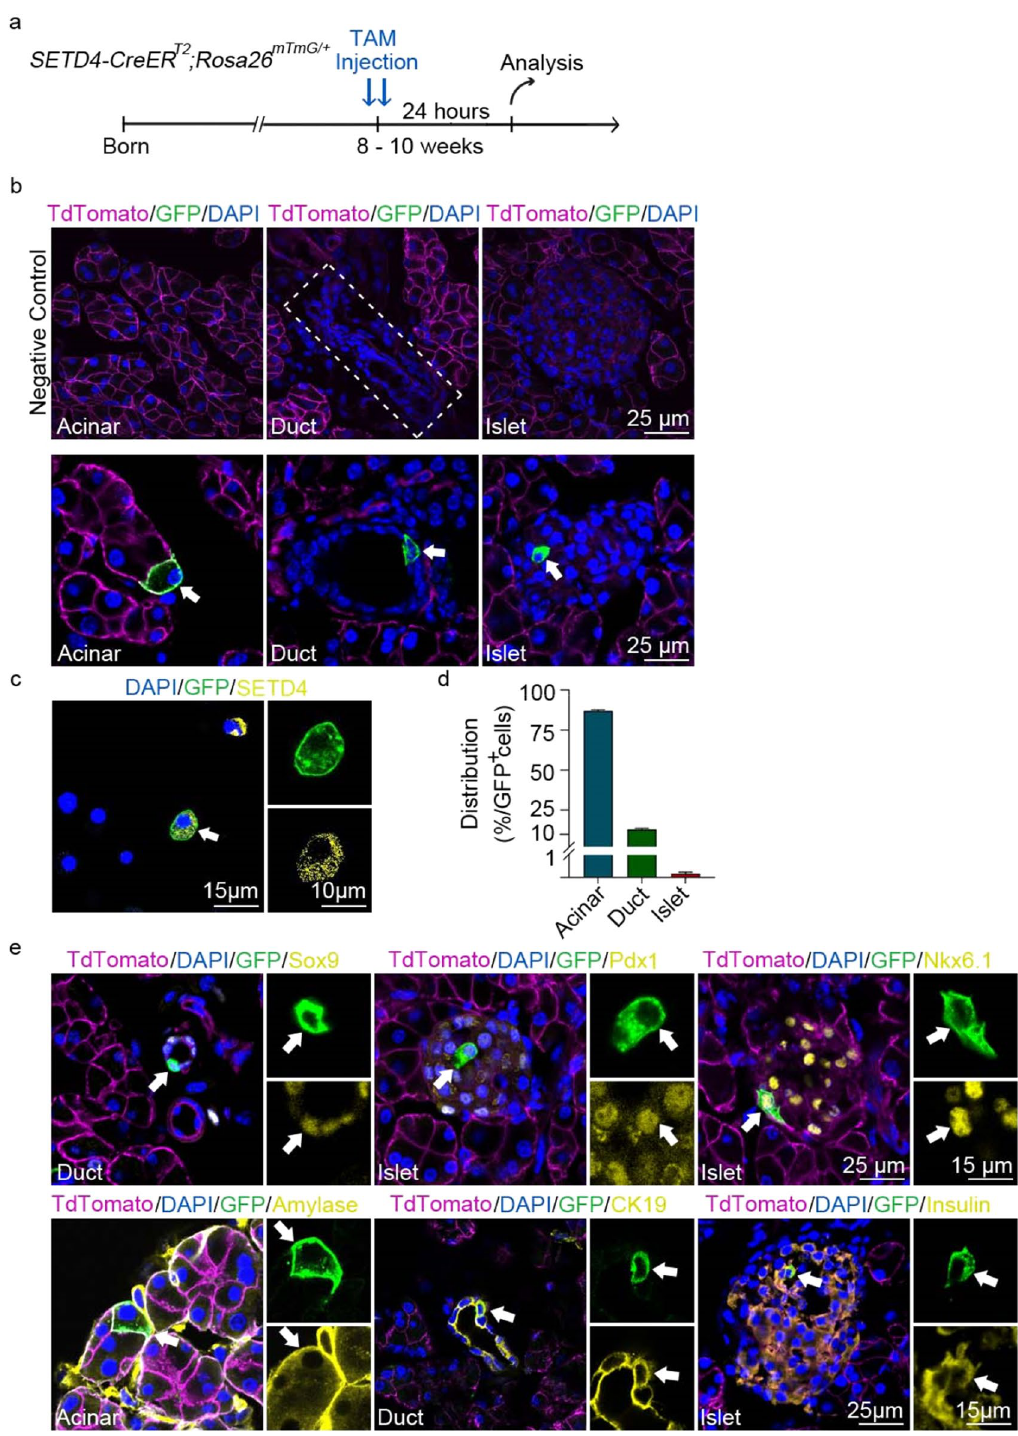
Figure 1. Identification of SETD4 + cells in the adult pancreas of SETD4-CreER T2 ; Rosa26 mTmG/ + mice. ( a ) Schedule of 24-h TAM-induction for SETD4 + cells identification in adult SETD4-CreER T2 ;Rosa26 mTmG/ + mice. ( b ) Representative fluorescent images of negative control of non-TAM induction and recombinant GFP + cells in acinar, ducts and islets 24 h after TAM-induction. Scale bar for each image, 25 μm. ( c ) Representative immunofluorescence for identification of GFP + cells in pancreas using an anti-SETD4 antibody by immunocytofluorescence. Scale bar for merged images, 15 μm. Scale bar for all spilt images, 10 μm. ( d ) Quantification of recombinant GFP + cells (SETD4 + cells) in acinar, duct and islet compartments. Recombination was assessed 24 h after TAM treatment with 80–100 high power fields randomly selected. Recombinant cells were counted manually and divided into acinar, duct and islet cells based on their respective morphology. ( e ) Representative immunofluorescence for recombinant (SETD4 + ) cells with amylase in the acinar, Sox9 and CK19 in the ducts, Pdx1, Nkx6.1 and insulin in the islets in adult SETD4- CreER T2 ;Rosa26 mTmG/ + mice. Scale bar for merged images, 25 μm. Scale bar for all spilt images, 15